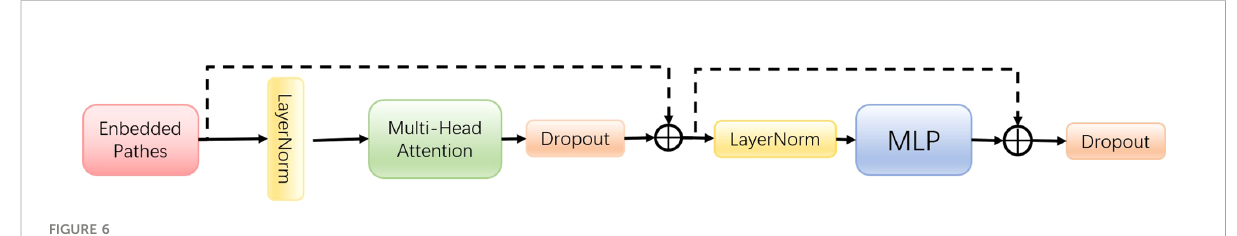
FIGURE 6 Transformer encoder